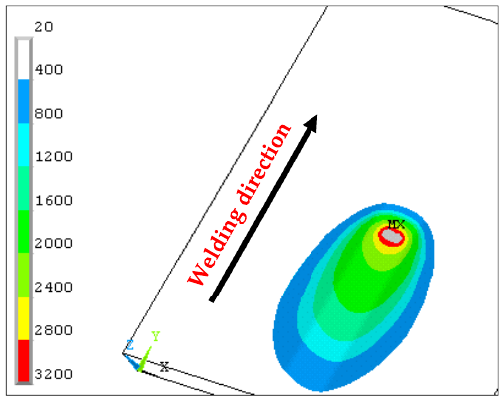
Figure 15. Contour of transient temperature field on top surface of tailored blanks.